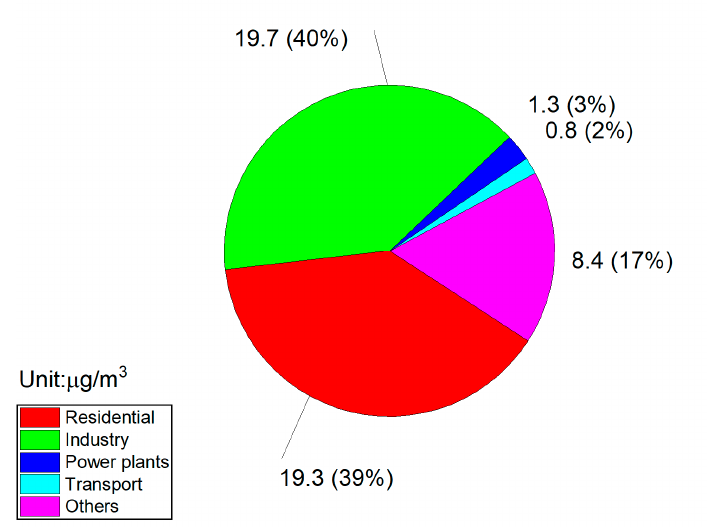
Figure 12. Percent distribution of total PM 2.5 across Hanoi from different emission sector.